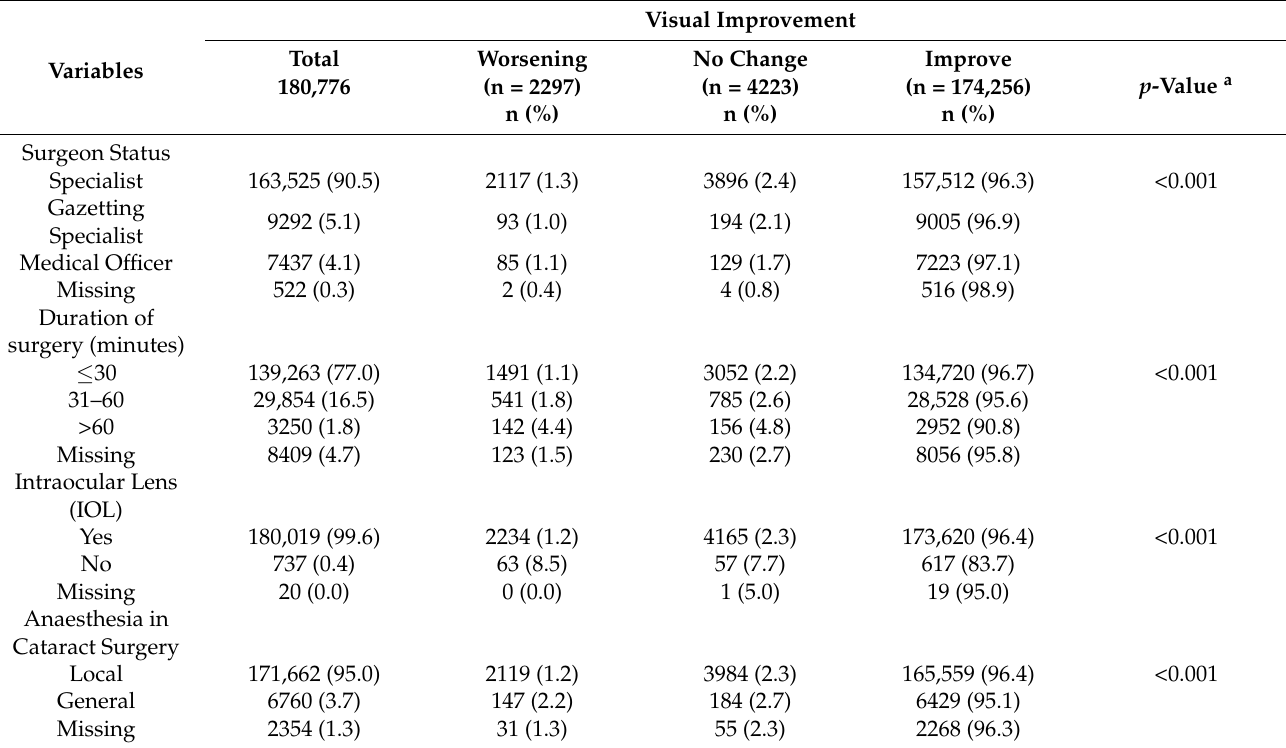
Table 4. Surgical factors according to the level of improved